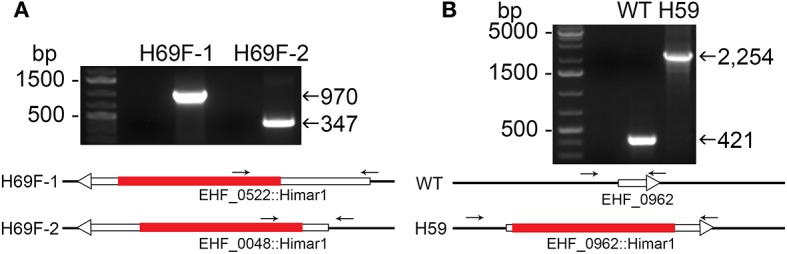
Insertion site-specific PCR to verify insertion site and flank PCR to verify clonality. (A) Specific insert PCR showing insertion sites at specific genomic loci of EHF_0522::Himar1 and EHF_0048::Himar1. (B) Flank PCR demonstrating clonality of EHF_0962::Himar1, arrows—PCR primers, red bar—Himar1 insert containing aad/mCherry, white boxes with arrow—ORFs. The lengths of ORFs and Himar1 insert were drawn to scale except primers that are enlarged.